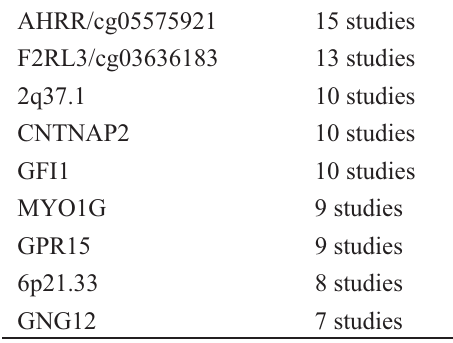
Table 2. Genes with significantly associated CpGs for smoking in seven or more